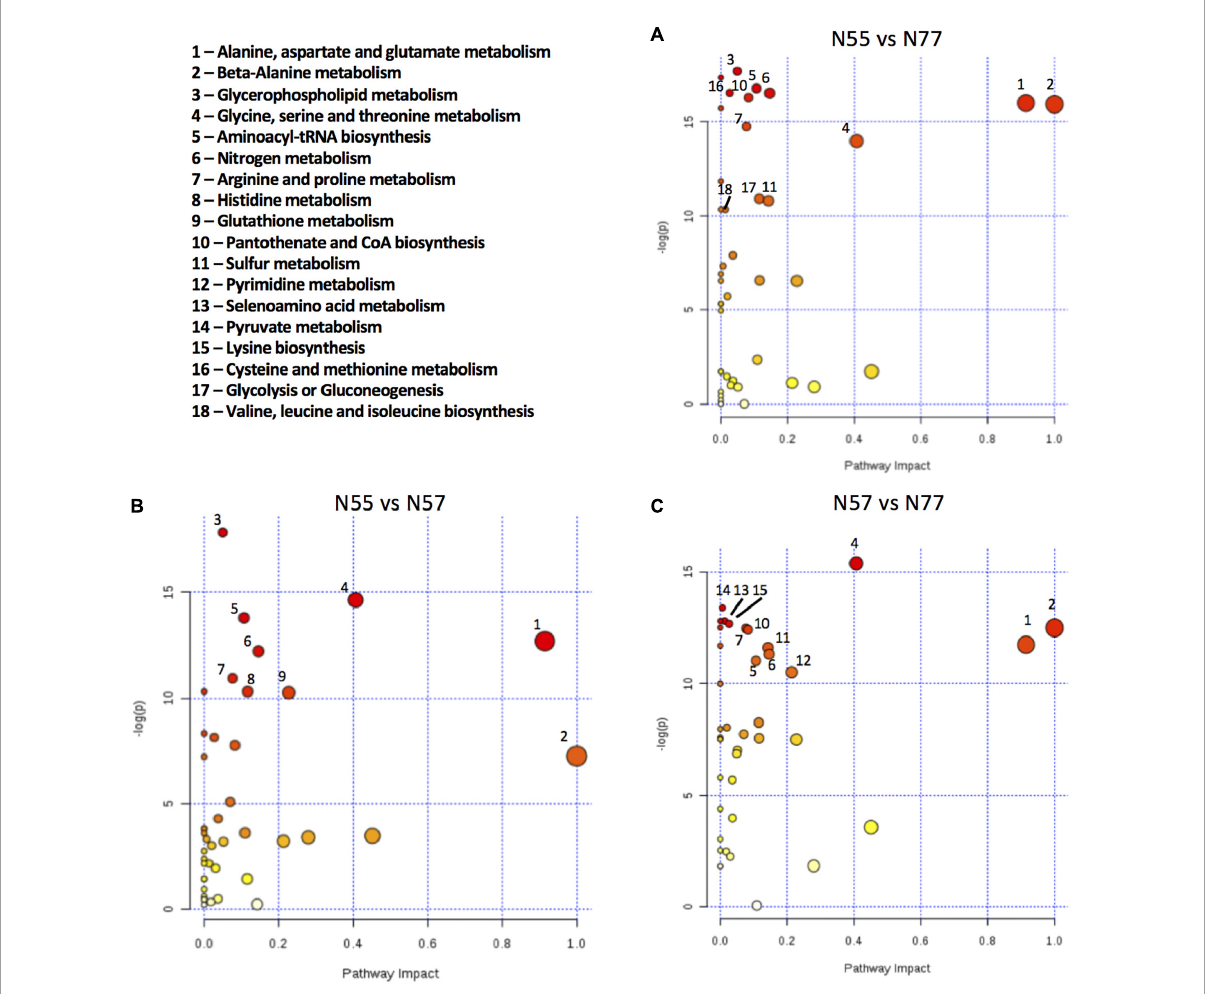
FIGURE6 Metabolic pathways altered between the conditions based on metabolite concentrations. Pathway Analysis using the metabolite concentrations, performed in Metaboanalyst, of pairwise comparison among the 3 conditions: (A) N55 vs N77, (B) N55 vs N57, and (C) N57 vs N77; using Staphylococcus aureus N315 as a pathway library reference. Pathways named here obey the criteria of negative logarithm of p -value higher than 10 (y axis) and a pathway impact > 0, or pathway impact > 0.5 (x axis). Circle size is proportional to the pathway impact value and the colour to the -log(p) value, increasing from white to